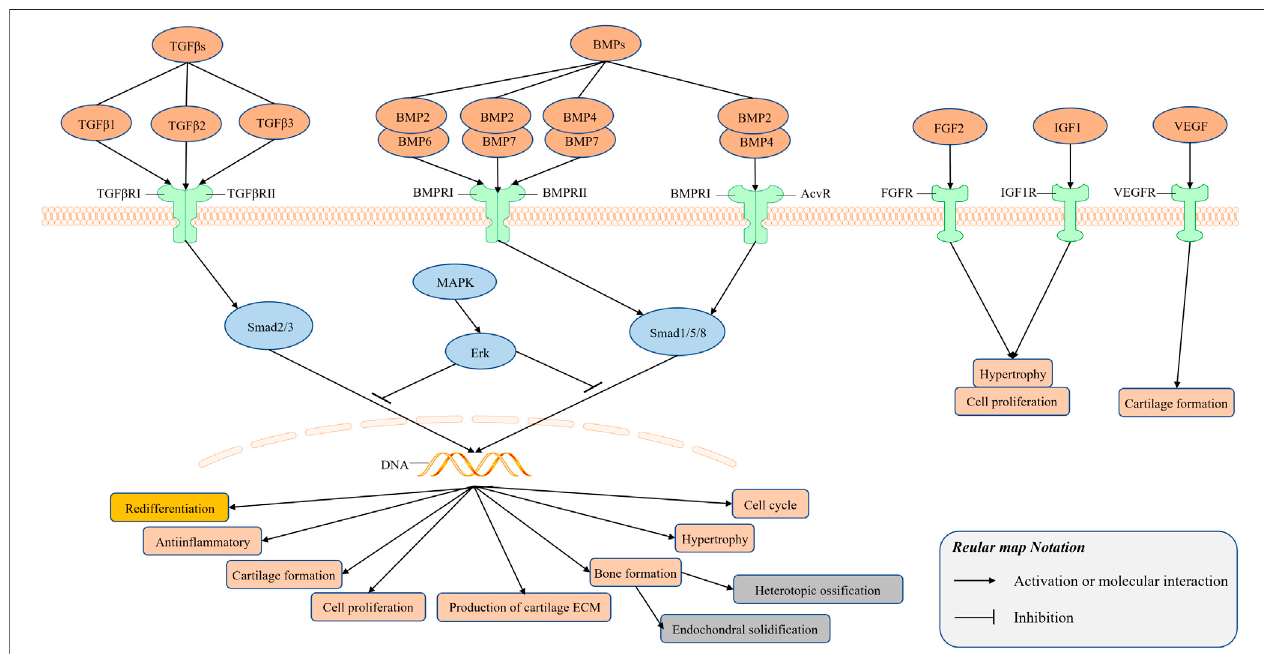
FIGURE 2 | Signal transduction mediated by growth factors plays an important role in the regulation of cell growth, differentiation and development in many biological systems. There exists cross-talk among the members of the TGF- β superfamily to regulate the redifferentiation of chondrocytes. TGF β s bind to its receptor TGF β receptor Ⅰ (TGF β R Ⅰ ) and Ⅱ (TGF β R Ⅱ ) to form a complex, and BMPs bind to its receptor BMP receptor Ⅰ (BMPR Ⅰ ) and Ⅱ (BMPR Ⅱ ), Acv receptor (AcvR) to form a